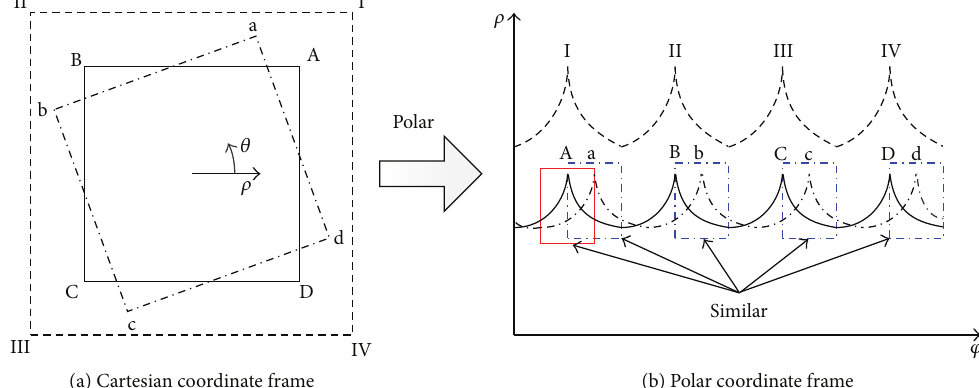
Figure 1: Coordinate transformation.